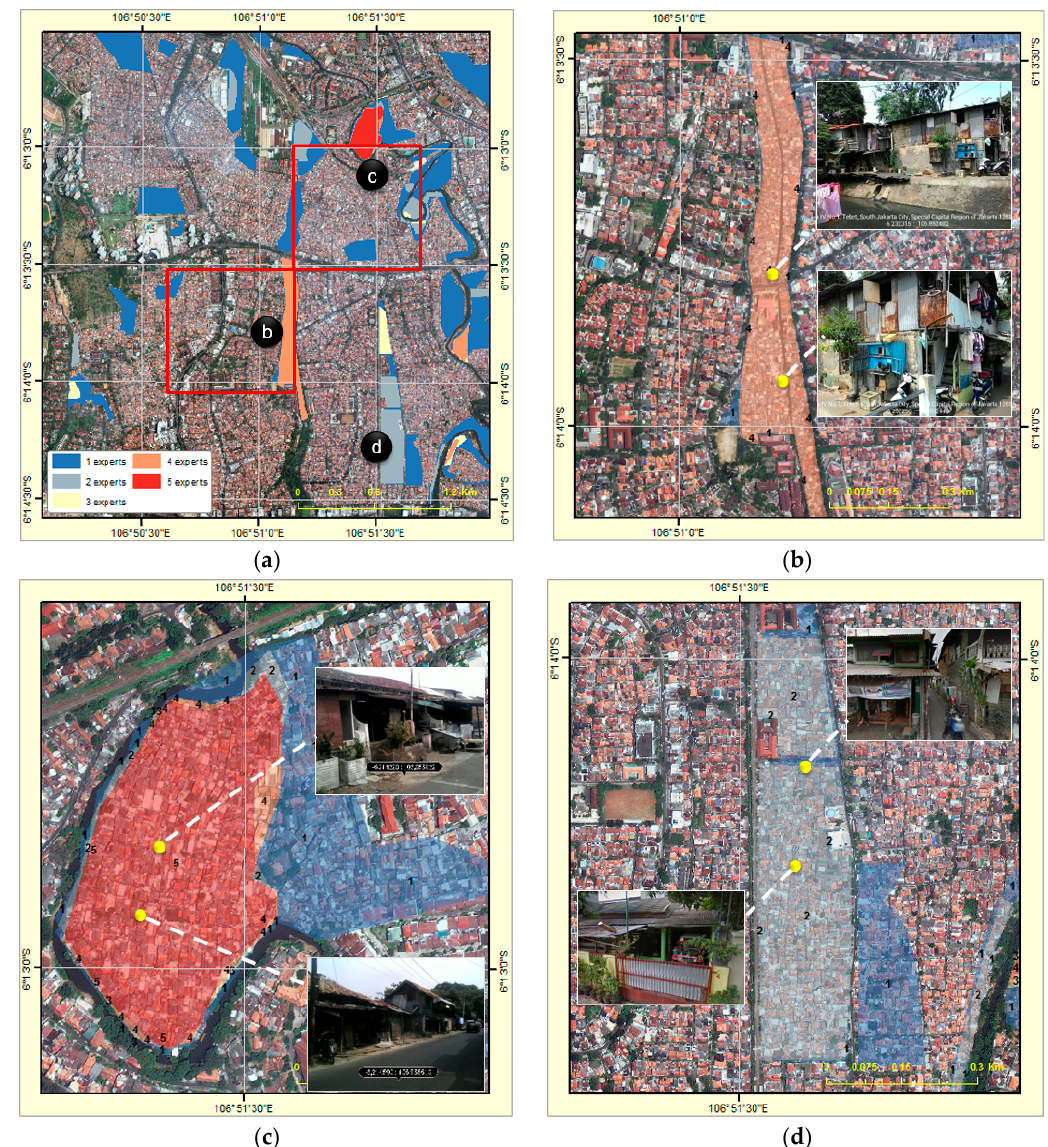
Figure 4. Slums extracted from manual delineation by different experts. ( a ) shows the different agreements of slum extents, where the red colour indicates areas with the highest agreement and the blue colour indicates the lowest; ( b ) shows the ground conditions of slums where four experts agreed; ( c ) shows the ground conditions of slums, which were indicated as a slum by all experts; ( d ) shows the ground conditions of a slum that was selected by one and two experts. The red boxes in ( a ) indicate our test areas.